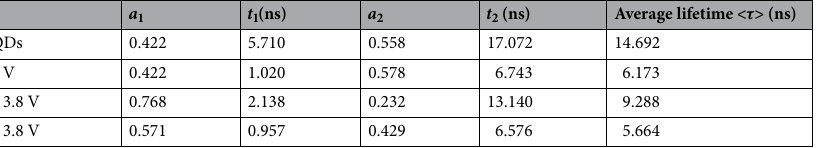
Table 1. Summary of the average lifetime of charge carriers from the QDs on quartz and full devices with zero bias, light-emitting mode (+ 3.8 V) and light-detecting mode (− 3.8 V).